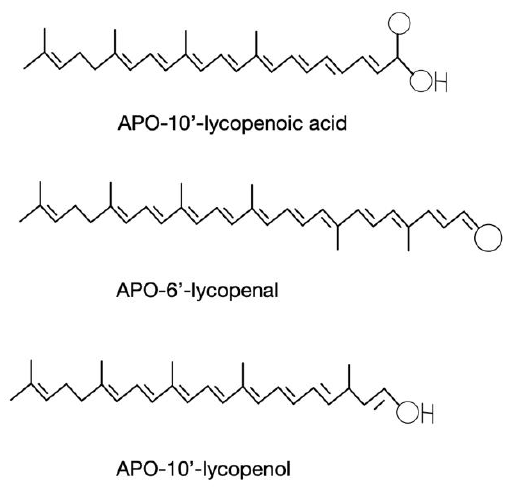
Figure 3. Examples of lycopene metabolites.